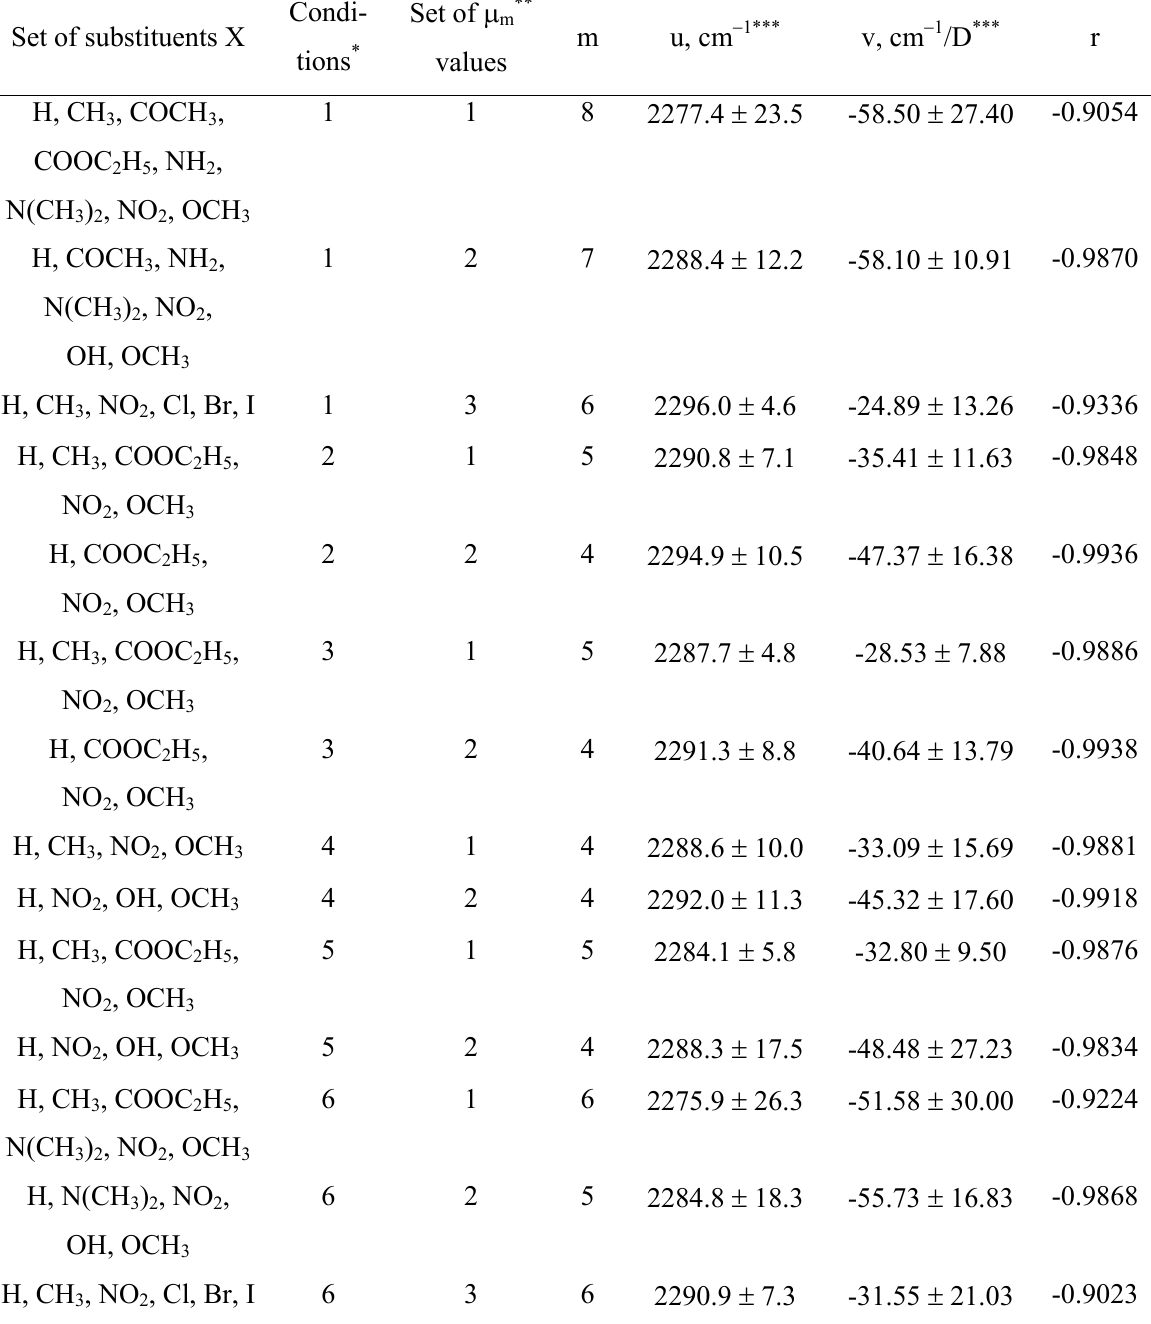
Table 4f. Correlations of stretching vibrational frequencies ( ν ) for fragment C-N + ≡ N bonds